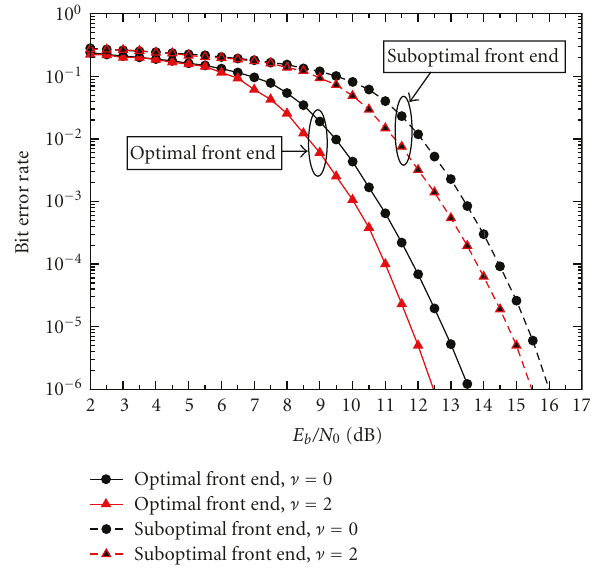
Figure 9: Performance of the proposed receivers for 4D-TCM 16 QAM and di ff erent prediction order, obtained with an 8-state 4D- TCM code applied to a 16 QAM constellation, signaling frequency f s = 64kHz, and carrier frequency f c = 340kHz. The HV power line channel is modeled as in Section